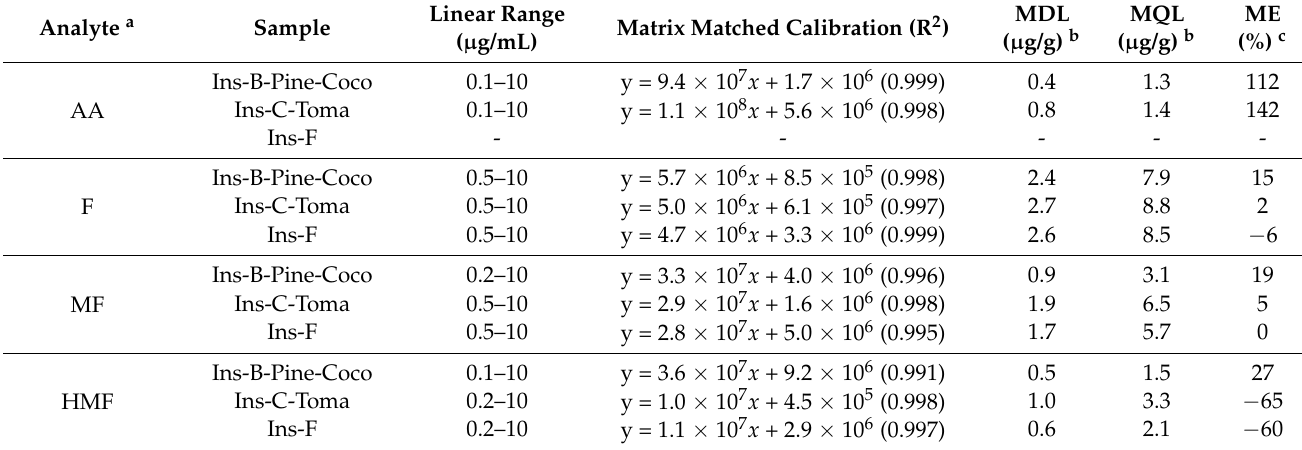
Table 3. Linearity, limits and matrix effect of the proposed method in selected insect-based samples.